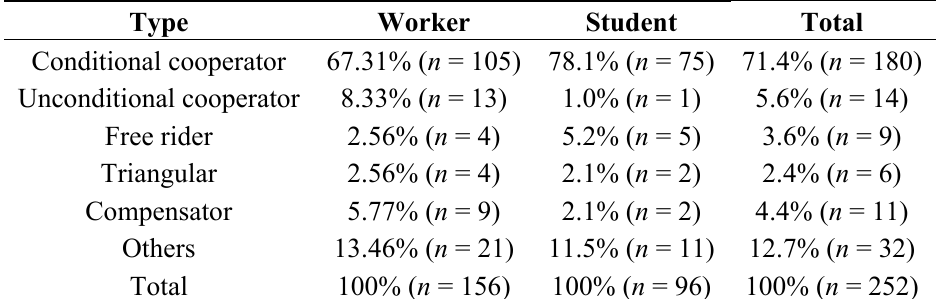
Table A8. Classification of types in the three samples (Strategy